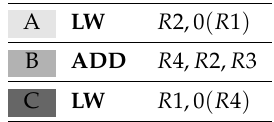
Table 4. Pipeline evolution of the proposed